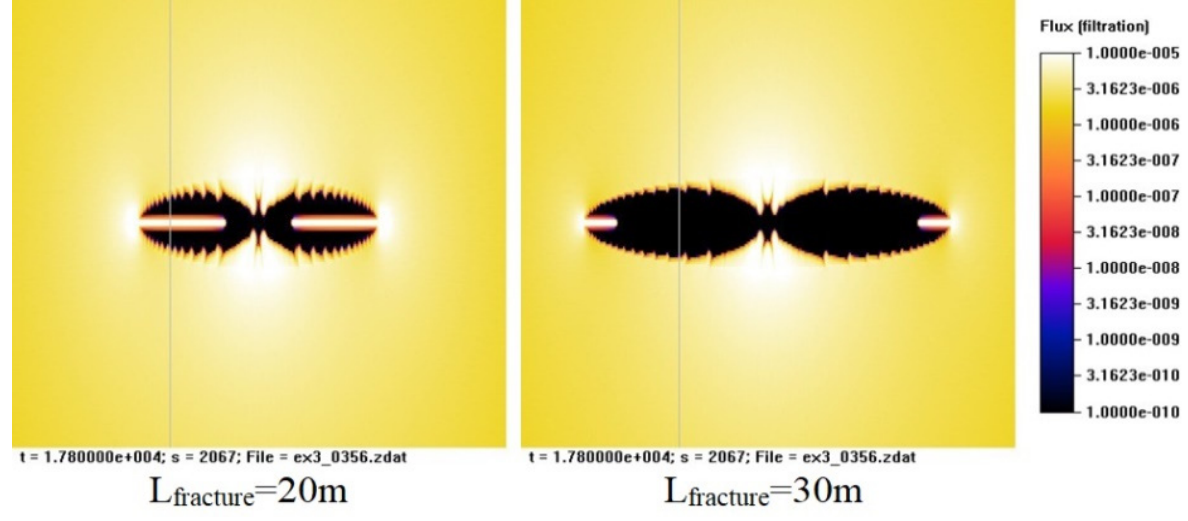
Figure 27. Oil seepage velocity approximately 5 h after the start of cleaning.